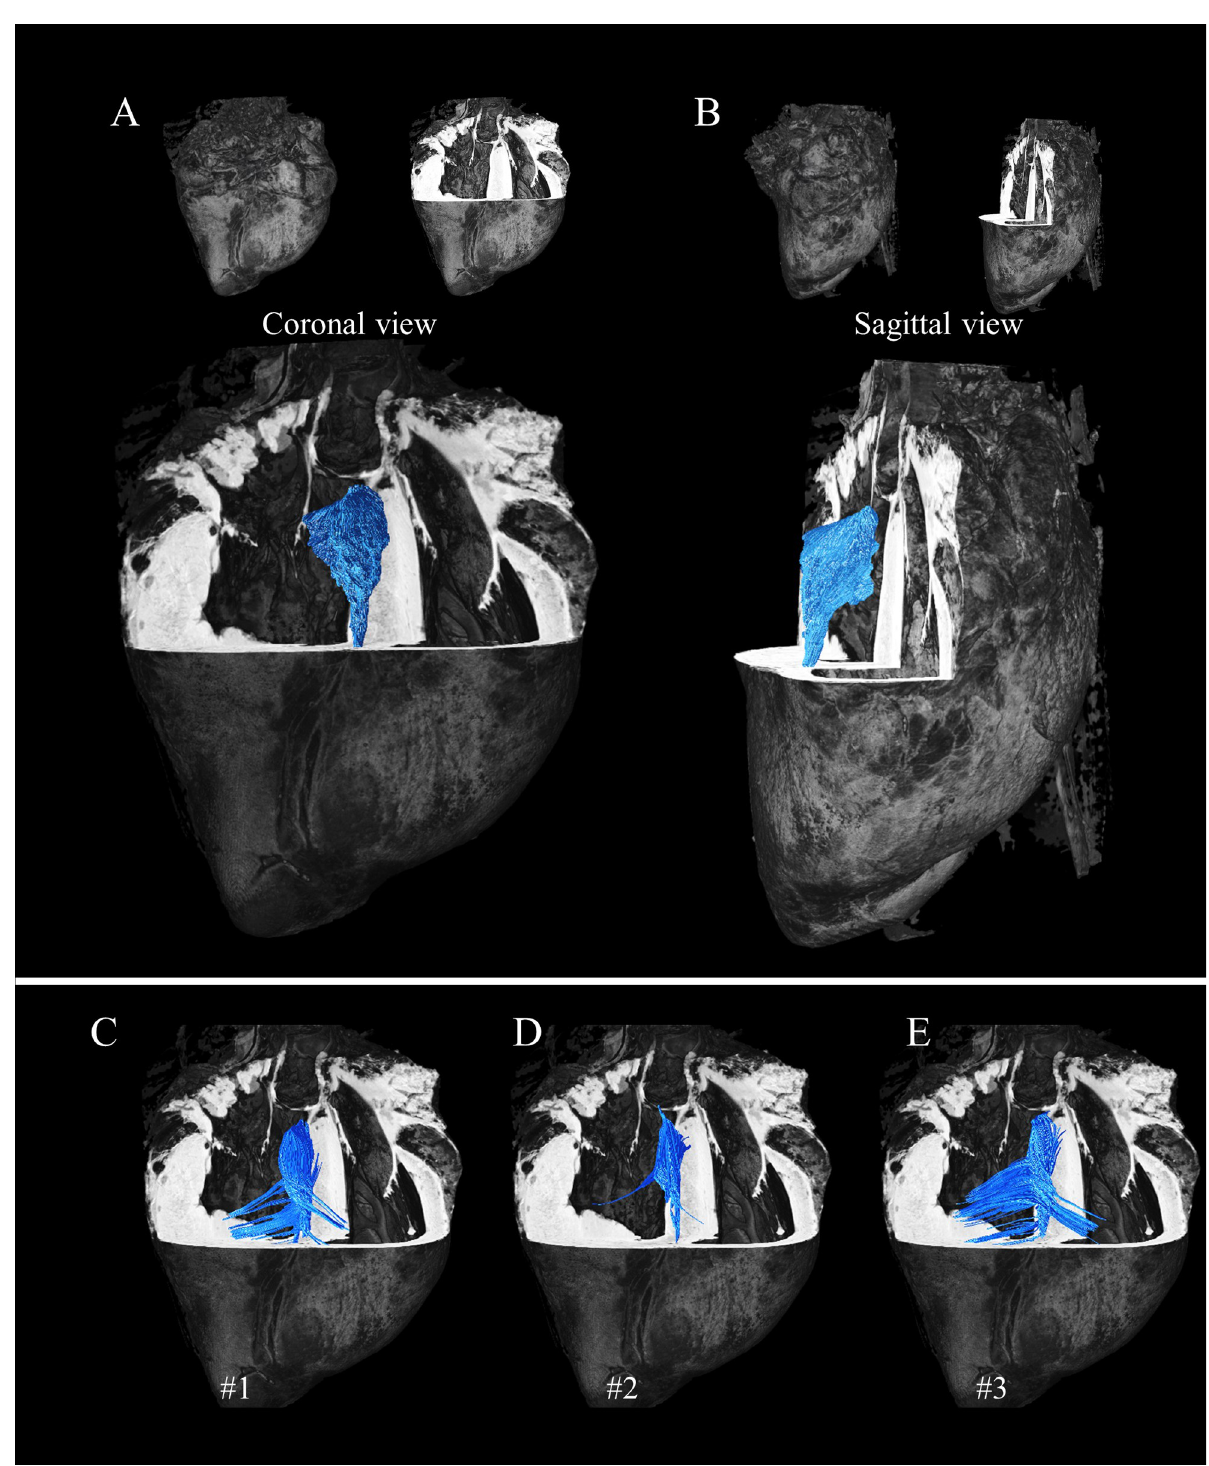
Fig 5. Streamlines of the posterior singularity with different tracking techniques on template and individual diffusion tensors. For each representation, the anatomical template is inserted for reference. Top) Streamlines were computed using a masking region of interest and the FACT algorithm on the primary eigenvector of the average tensor in template space and displayed in coronal (A) and sagittal view (B). Down) A different tracking technique is shown. Few seeds were manually defined, then streamlines were generated for sample #1 (C), #2 (D), #3 (E) using the Tensor_Det algorithm on each individual tensor in native space and warped into template space without ROI restriction.